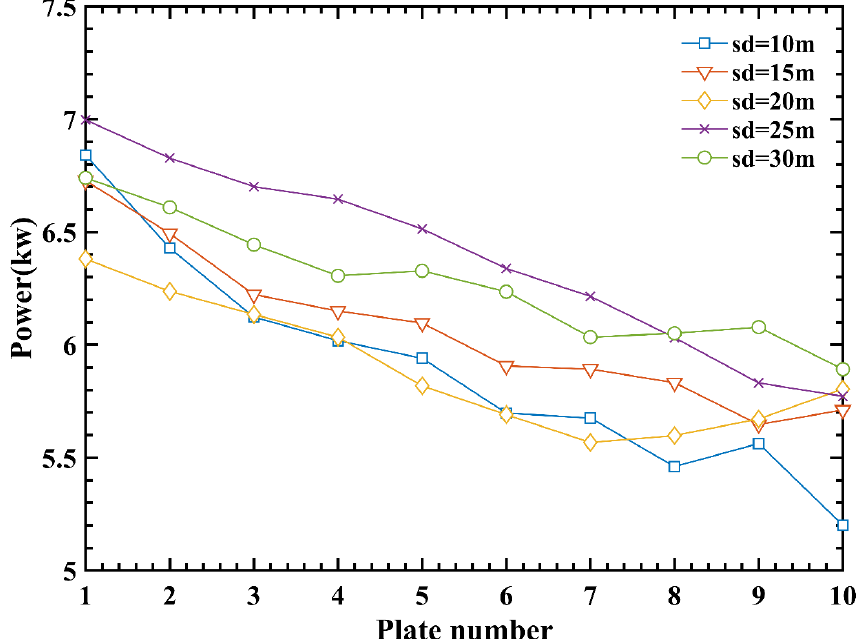
Figure 16. Effect of different spacing on array S-PWEC power.